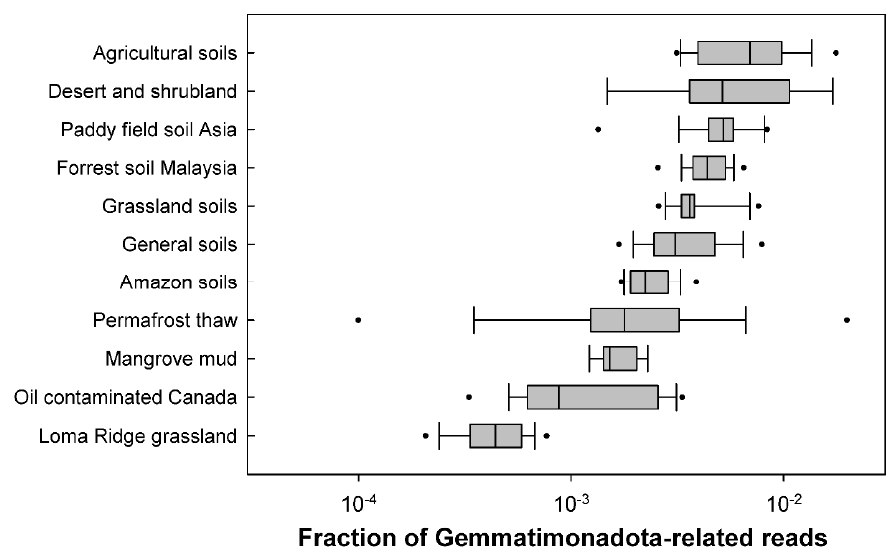
Figure 6. Gemmatimonadota-related reads recovered from different types of soils. The figure is based on metagenomic survey data published in [17]. A unique environment where Gemmatimonadota have been found is in the glacier forefields of East Antarctica [76] and the McMurdo Dry Valleys, Antarctica. The soils of McMurdo Dry Valleys, originally thought to be sterile or to have low diversity of micro- organisms [46], are dominated by Actinobacteriota, Acidobacteriota, Gemmatimonadota, and Bacteroidota [43,77]. Gemmatimonadota were suggested to be adapted to dry envi- ronments because they occur in high relative proportions in semiarid and arid soils and deserts [46,78–82]. Moreover, they were shown to be positively influenced by rainfall re- duction and to be more abundant during drought [42]. Finally, even in soil aggregates, their relative abundance is higher in dry and semi-aerobic inner parts of microaggregates [83]. The pH is another factor that influences the abundance of Gemmatimonadota in soils, and it seems that they prefer neutral pH over acidic pH [40,84,85]. Interestingly, Gem- matimonadota dominated in alkaline [86] and highly saline soils and represented almost 17% of all bacterial reads [87]. Gemmatimonadota were also found to be one of the bacterial phyla that are posi- tively correlated with vegetation restoration. As one of top-ten most abundant phyla that strongly increased with revegetation, their relative abundances were above 2% [88] and